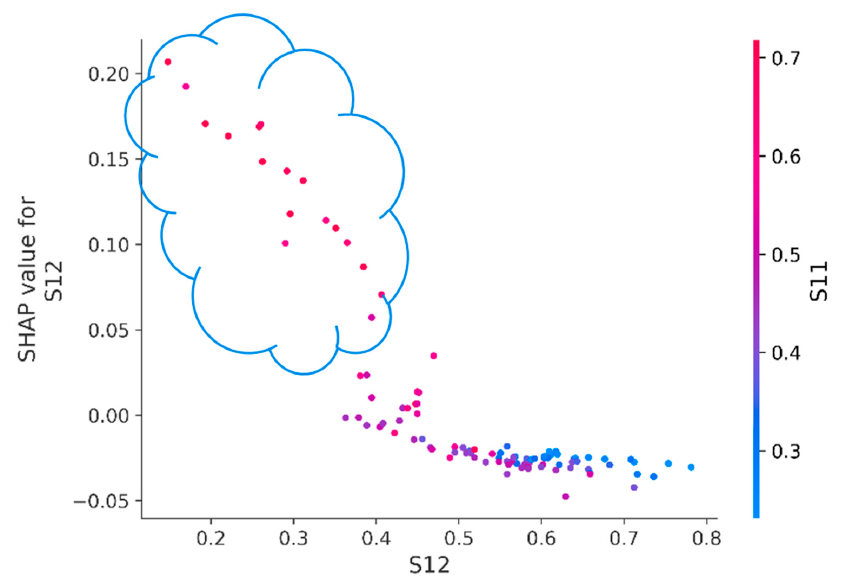
Figure 9. Dependence of SHAP values of the S12 feature on its value (the gradient indicates the value of the S11 feature). A cluster of engines with SHAP values for the S12 attribute higher than 0.025 is highlighted by the cloud.